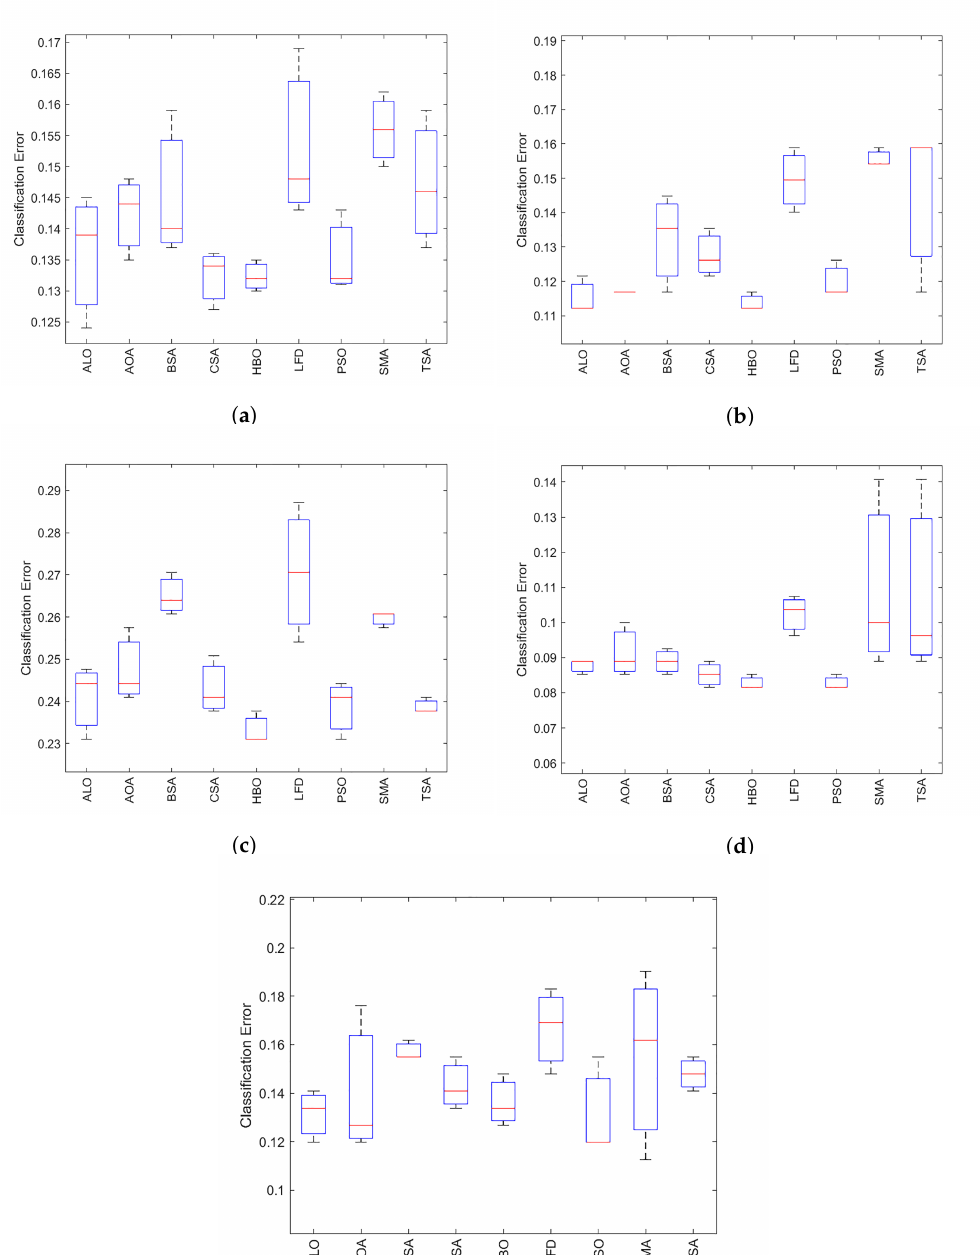
Figure 7. Boxplots of the results achieved by the B_HBO regarding classification error over German, Glass, Heart-C, Heart-StatLog, and Hepatitis datasets regarding classification error. ( a ) Classification error of the proposed approach for German dataset. ( b ) Classification error of the proposed approach for Glass dataset. ( c ) Classification error of the proposed approach for Heart-C dataset. ( d ) Classifica- tion error of the proposed approach for Heart-StatLog dataset. ( e ) Classification error of the proposed approach for Hepatitis